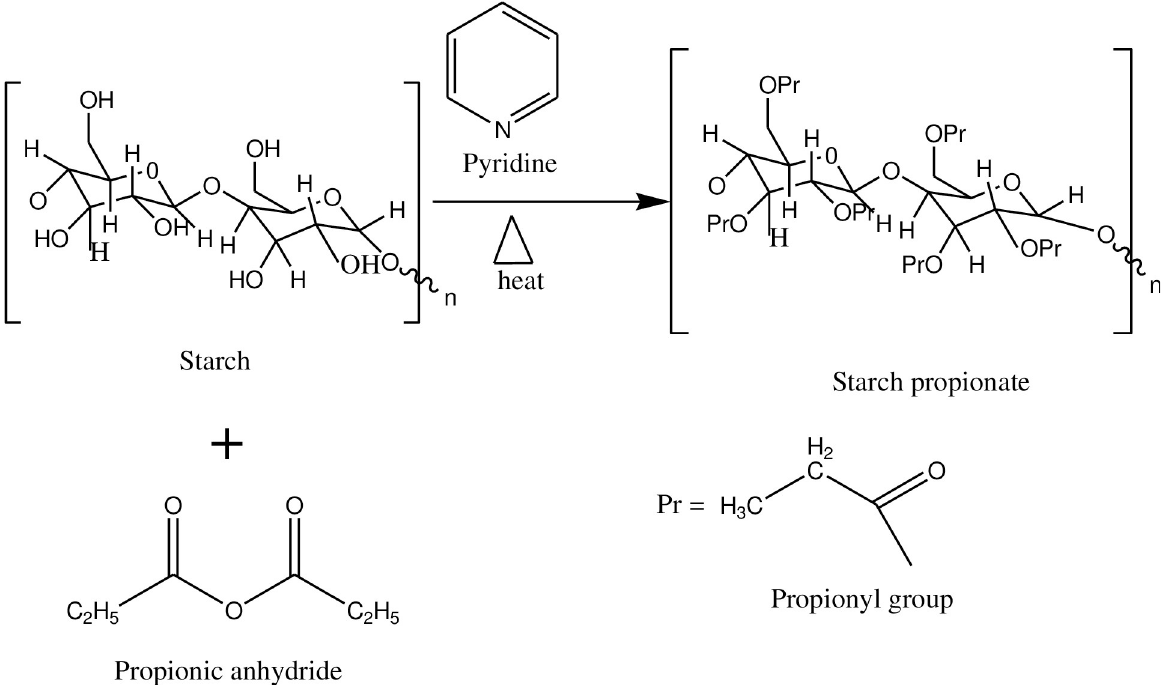
Fig 1. The chemical reaction of starch and propionic